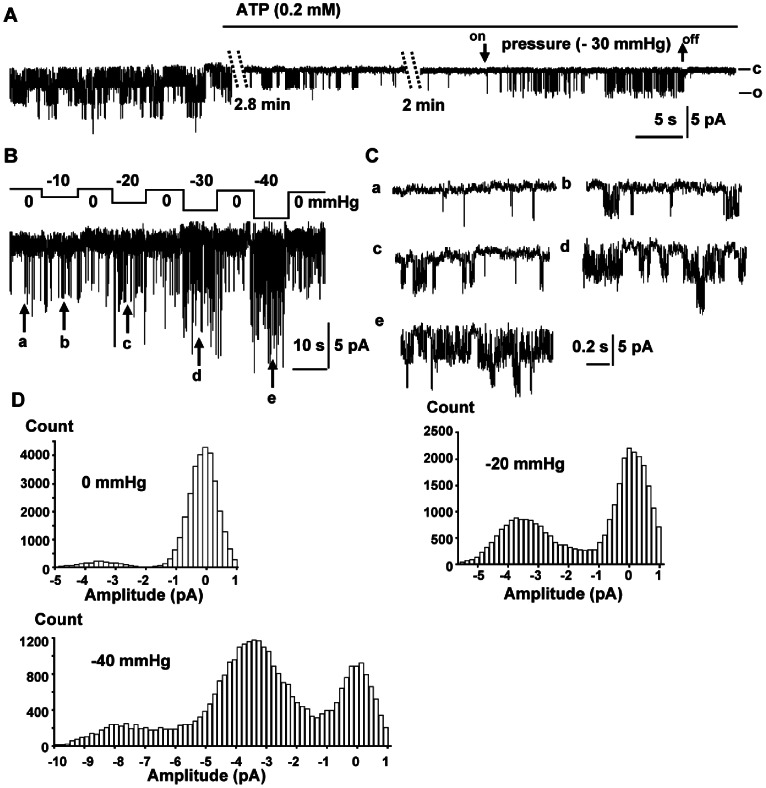
KATP response to suction.Current was recorded at −60 mV in symmetrical solutions at the indicated pressures. A: Two data segments of 2.8 min with 2 min of intervening data omitted to show steady state behavior. KATP was inhibited by 0.2 mM ATP and activated by suction. B: KATP response to pressure ladders. C: Traces a to e show longer term activity and are marked with corresponding letters in B. D: All-points histograms were constructed using the data segments (1.6 sec each) in B at 0, −20 and −40 mm Hg, respectively.